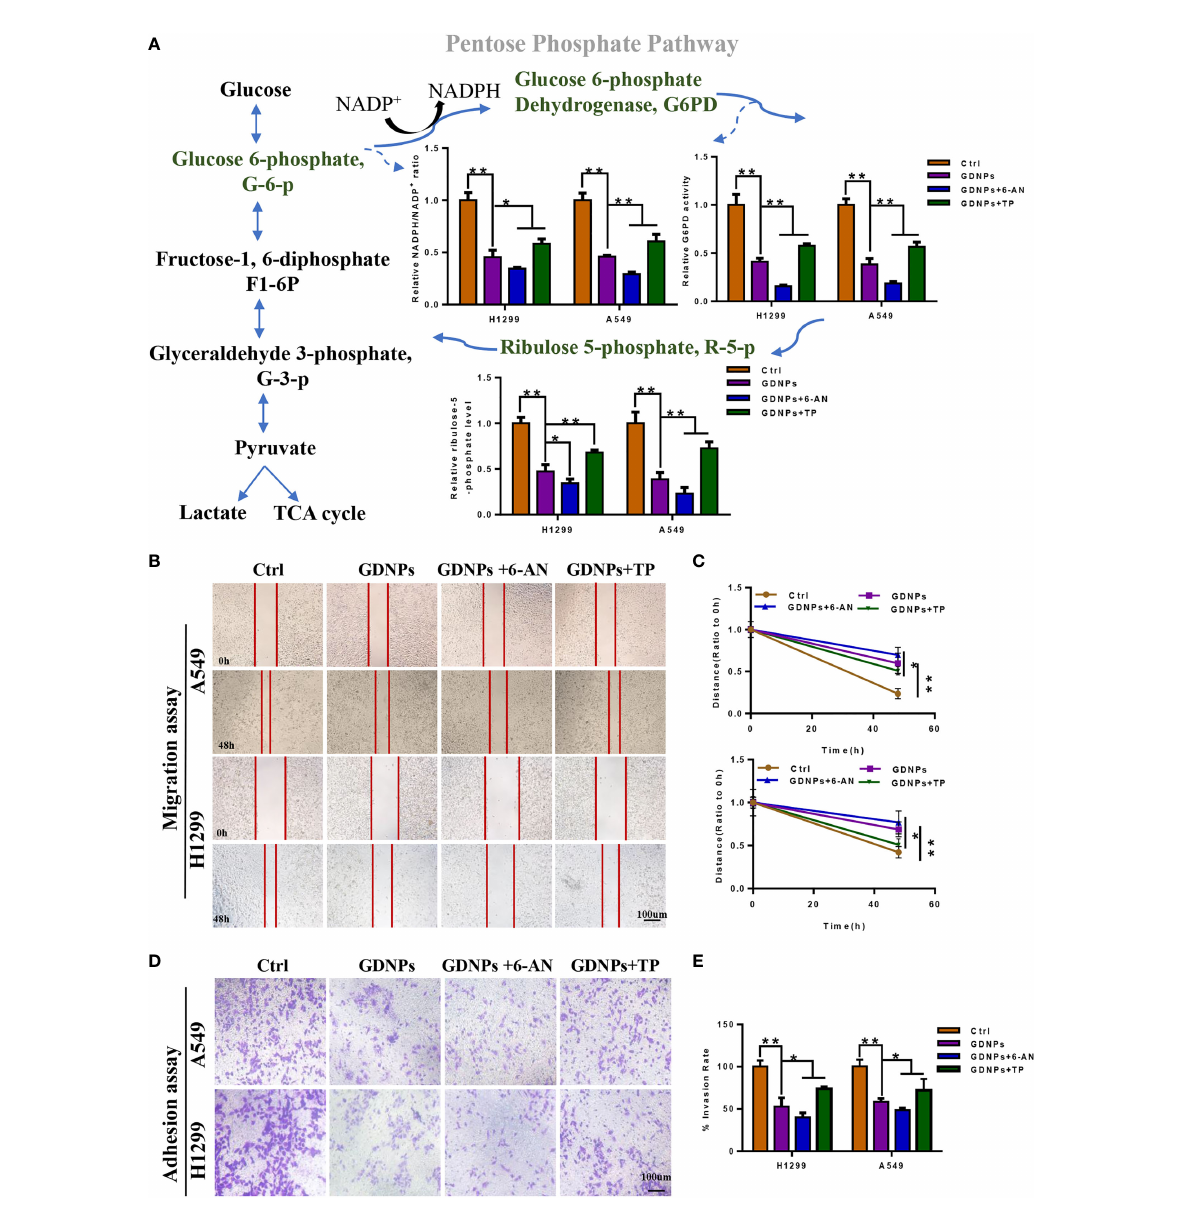
FIGURE 8 GDNPs and 6-AN can synergistically inhibit pentose phosphate pathway activities. (A) Contents of NADP + /NADPH and relative G6PD activities in A549 and H1299 cells of control and treated groups. Detection of contents of intermediate pentose phosphate pathway metabolites in A549 and H1299 cells treated with GDNPs and 6-AN. (B-E) Effect of GDNPs and 6-AN on migration and invasion of A549 and H1299 cells. Images were obtained at 200× magni fi cation. Cells were then treated with 6-AN (50 µM). Data are presented as the mean ± SD of three experiments (*P < 0.05 and **P <